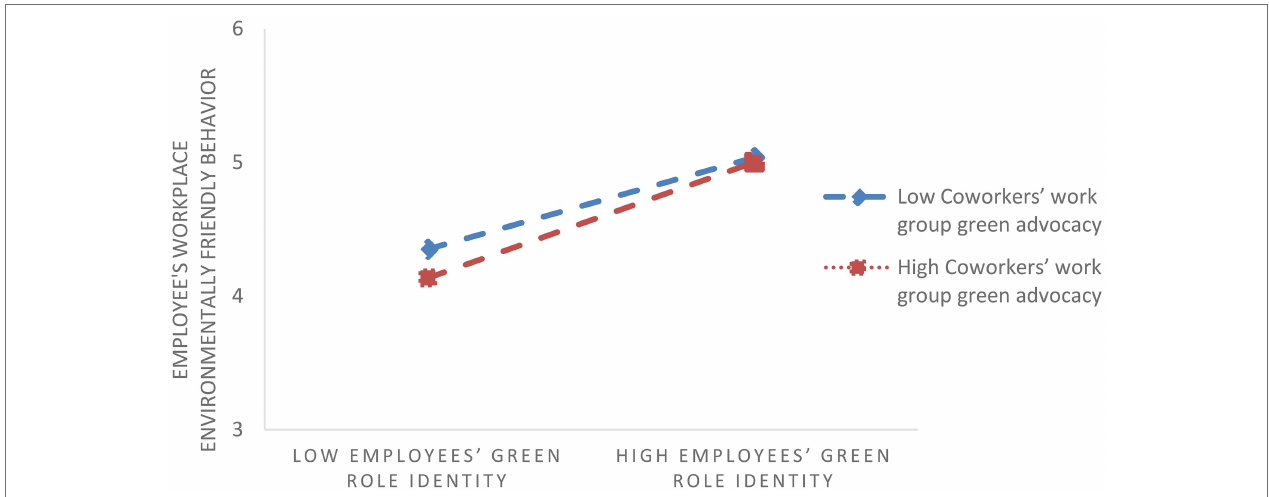
FIGURE 3 | Interaction between employees’ green role identity and coworkers’ work group green advocacy in predicting employees’ workplace environmentally friendly